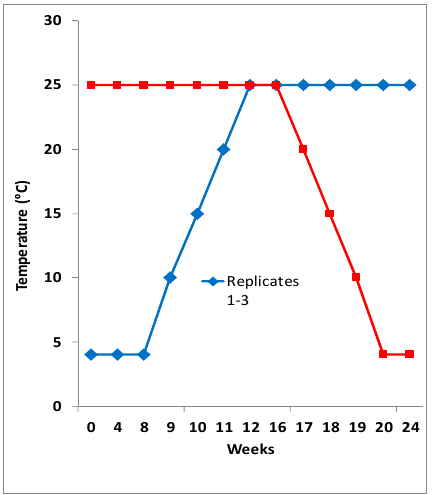
Figure 1. The temperature manipulations of manure samples. The graph shows isolation of ceftiofur or cefotaxime resistant Gram-negative bacteria from different manure samples incubated under anaerobic conditions for over 20 weeks at two temperature regimes (4 °C or at 25 °C). The gradual increase or decrease in temperature is shown in blue and red lines.